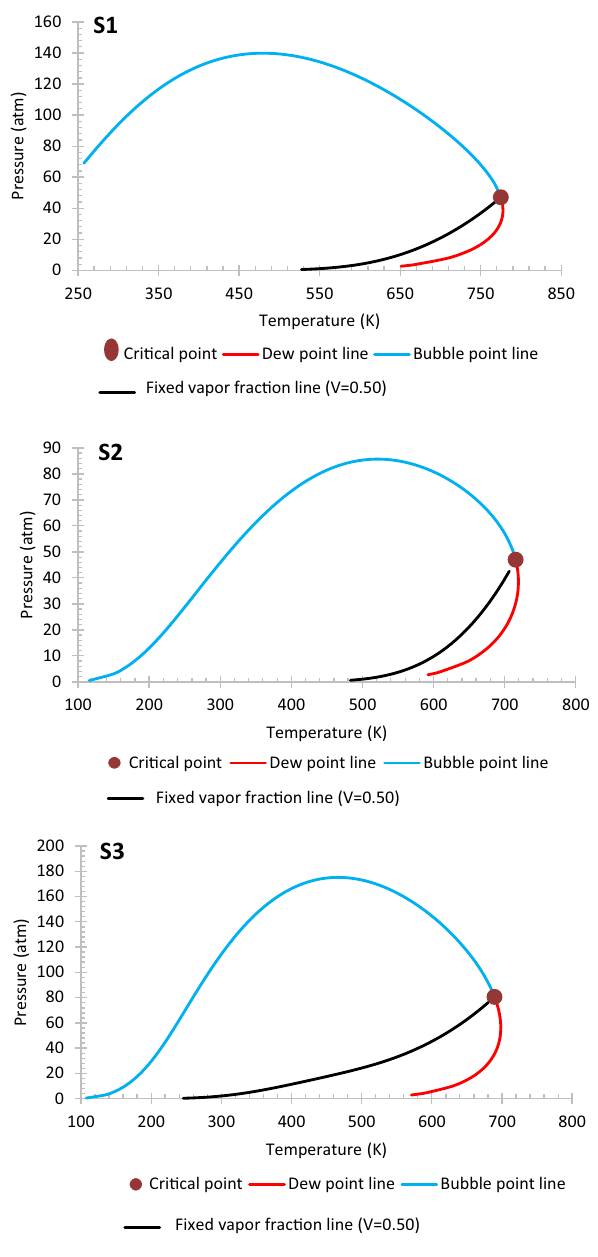
Fig. 3 Schematic two-phase diagrams of three oil samples used in this